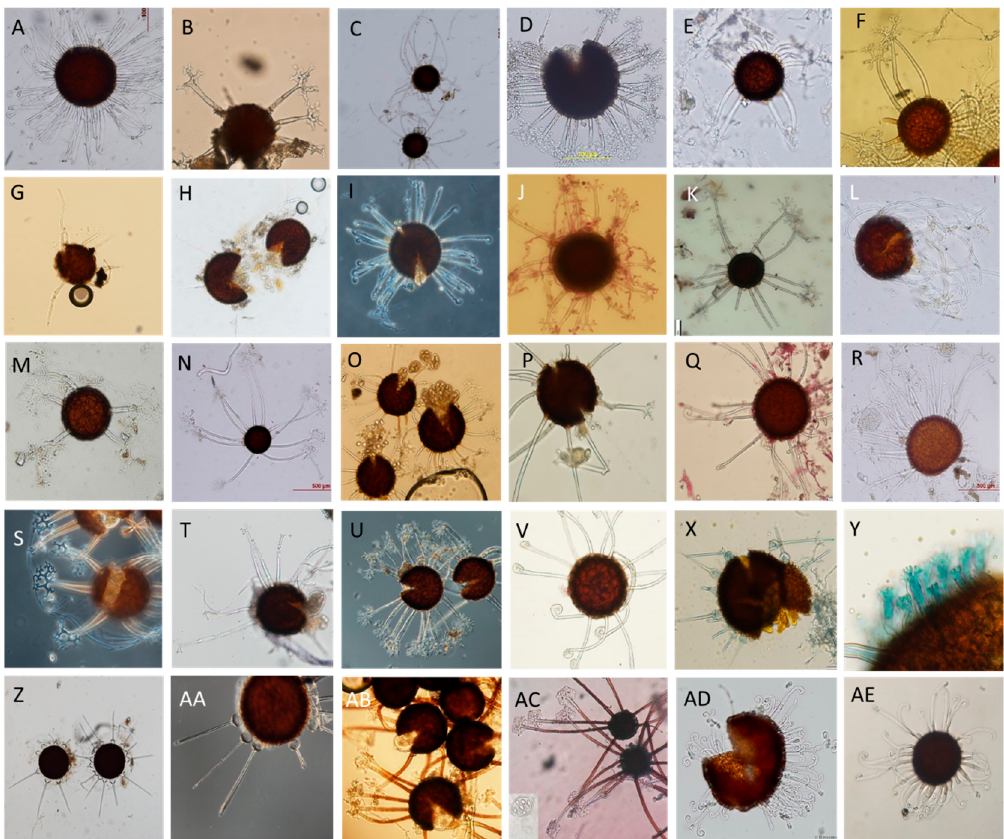
Figure 3. Variability of chasmothecia of selected species: A — Erysiphe adunca var. adunca ( Salix caprea ,